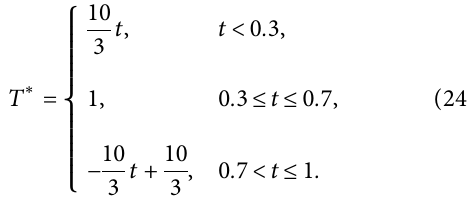
Figure 5: The TACTC with AW: (a) the tracking curve of total traction torque, (b) the tracking error curve of total traction